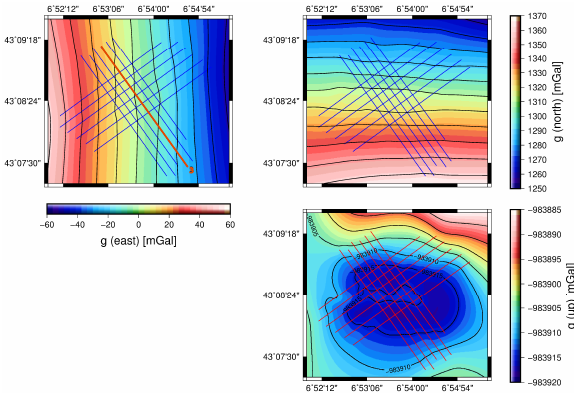
Figure 6: Superposition of 12 profiles with variations of gravity field vector components. Results of Part 5. and 6. will be relative to the profile number 3 , which has been highlighted on the first